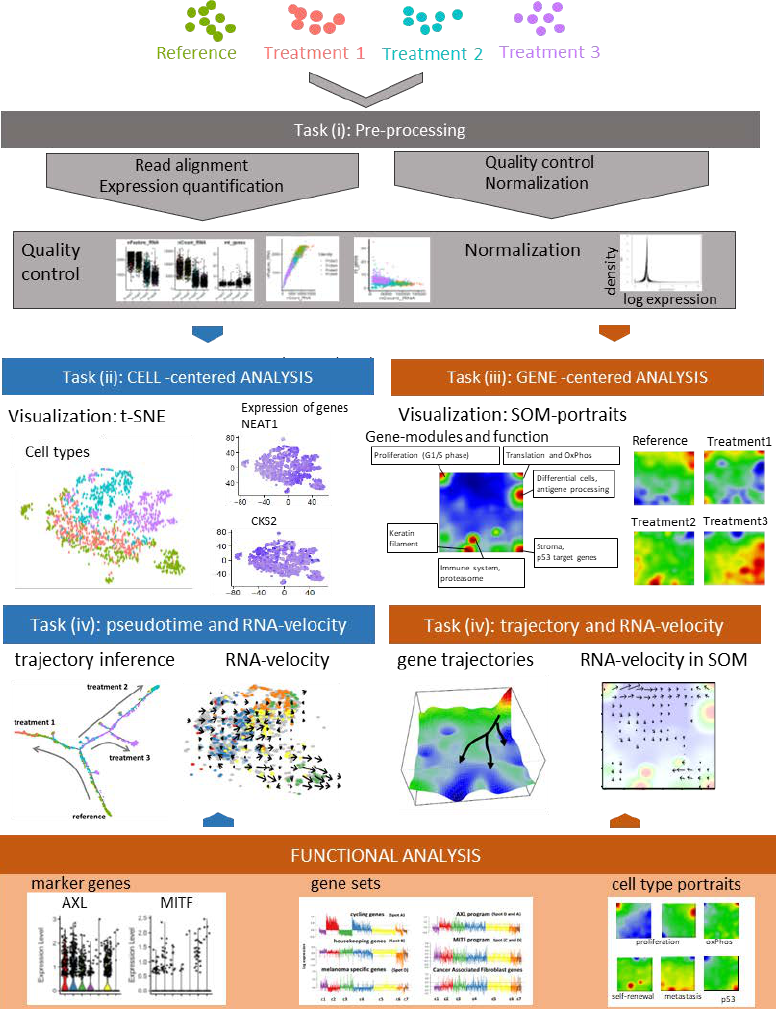
Figure 1. Principles of single-cell analyses based on melanoma cells analyses: A schematic repre- sentation of single-cell analyses is shown. Analysis starts with classical read alignment and quality control and normalization measures as in bulk RNA-seq. Subsequent analysis of transcriptomic cell clusters is performed by t-distributed stochastic neighbor embedding (t-SNE) as described in the text. Individual genes ( NEAT1 , CKS2 ) may be mapped onto clonal structures. Alternatively, self-organizing maps may be chosen, which represents a gene-based clustering method of cellular subclones. Pseudotime dynamics shows different trajectories of treatment resistance under three different treatment conditions which may also be demonstrated by RNA-velocity analysis. Marker genes for treatment resistance are found in different subclones and are part of larger gene sets or cell type